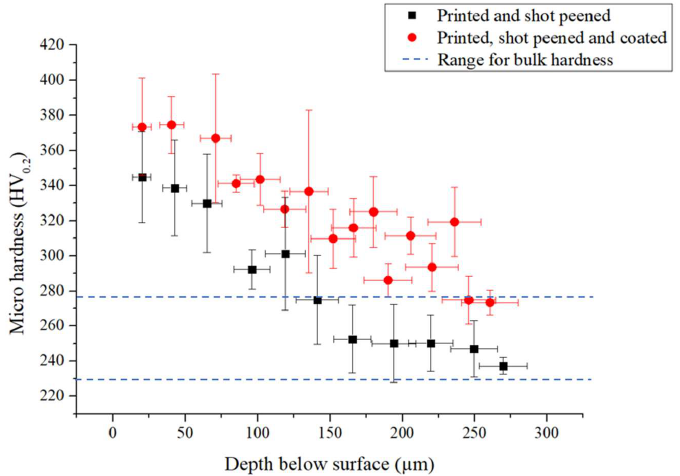
Figure 10. Microhardness-depth profile for printed and shot peened and printed, shot peened and coated 316L SS.